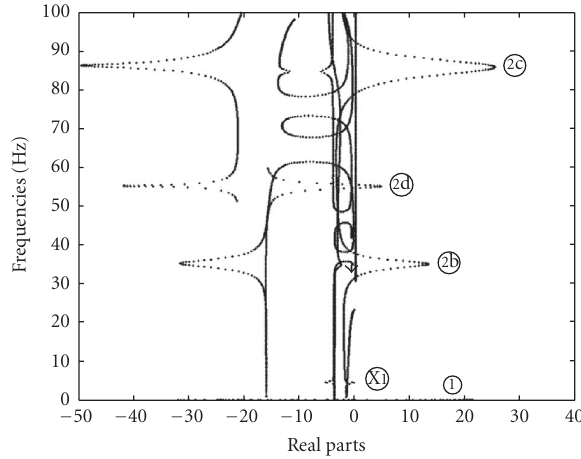
Figure 7: Campbell diagram for a two-bladed rotor.